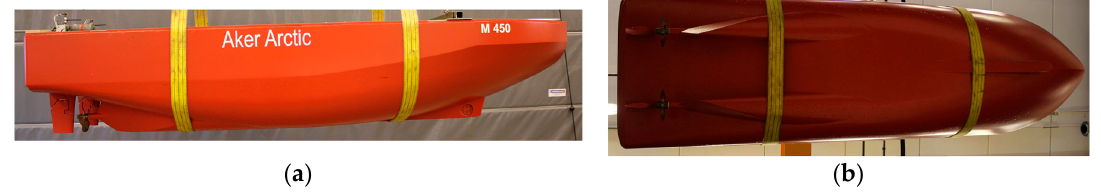
Figure 12. Side view and bottom view of the ferry model NB550 (In Appendix C of AARC Report A-